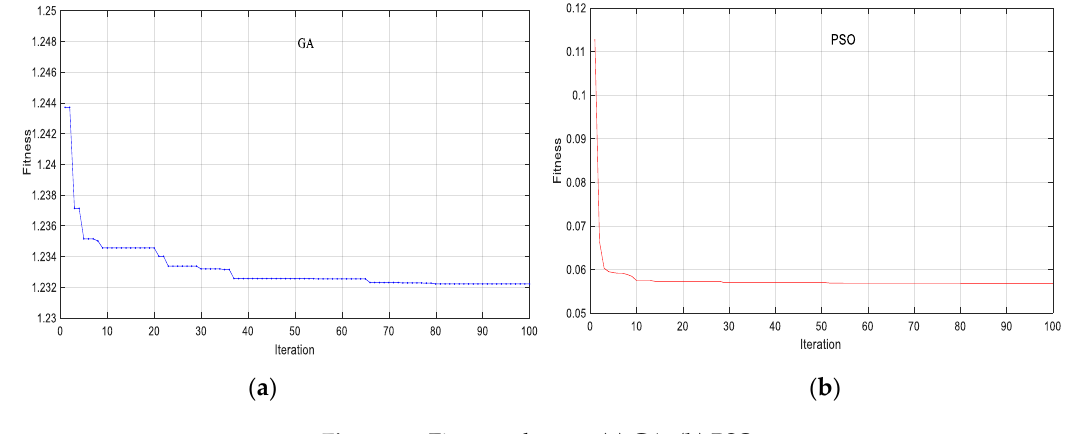
Figure 17. Fitness tolerance ( a ) GA; ( b ) PSO.